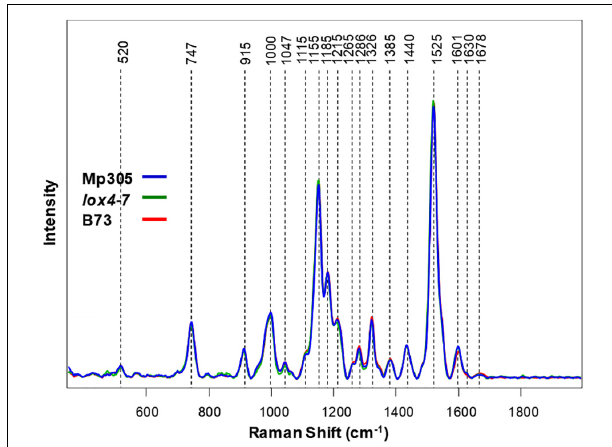
FIGURE 3 | Raman spectra collected from leaves of non-inoculated control plants from all three maize varieties.